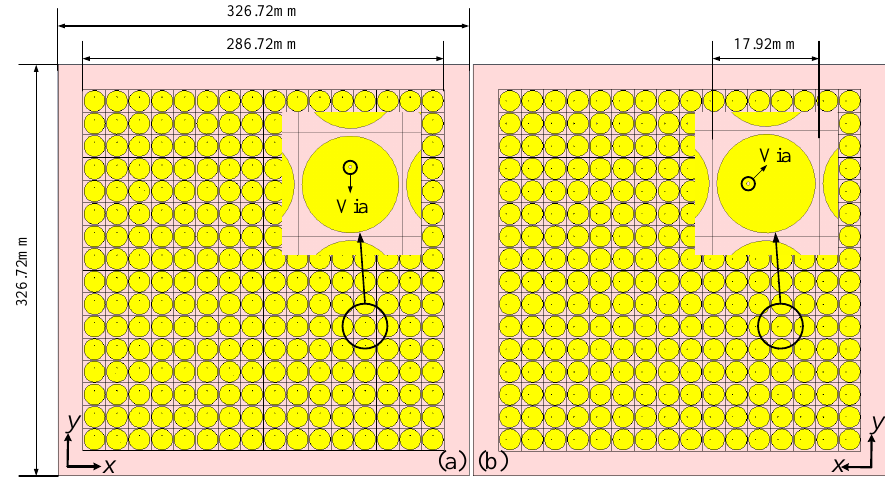
Figure 6. The simulation model of the proposed metasurface: ( a ) Front view. ( b ) Back